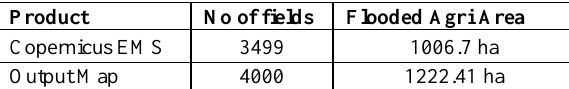
Table 3. The number and area of agricultural fields detected as flooded by Copernicus EMS and this study.